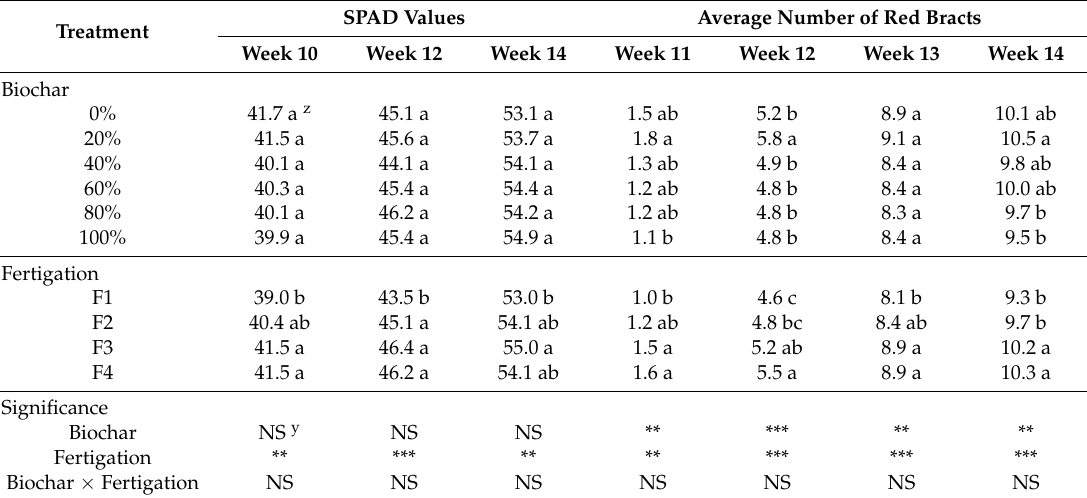
Table 6. Leaf Chlorophyll index [Special Products Analysis Division (SPAD) values] at weeks 10, 12, and 14, the average number of red bracts from weeks 11 to 14, and final root visual rating of ‘Prestige Red’ poinsettia 15 weeks after transplanting in root substrate amended with six different percentages of biochar and fertilized with four fertigation regimes.